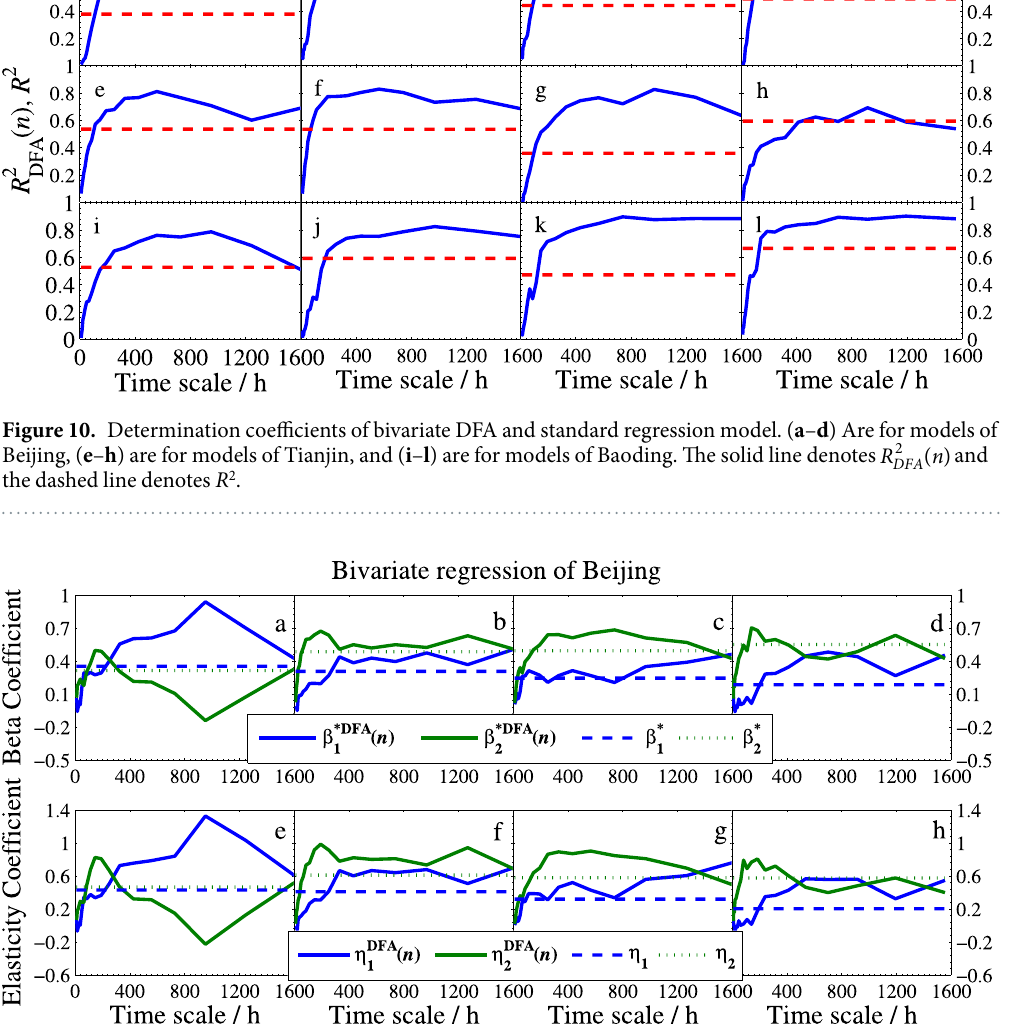
Figure 11. Beta coefficients and elasticity coefficients of bivariate DFA and standard regression model of Beijing. The four columns from left to right are for winter, spring, summer, and fall, respectively. The subscript 1 of β * and η denotes Tianjin and 2 denotes